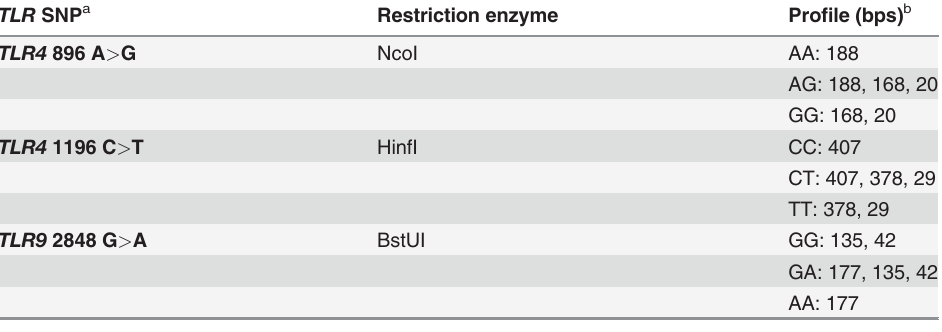
Table 2. Length of restriction fragments and genotypic